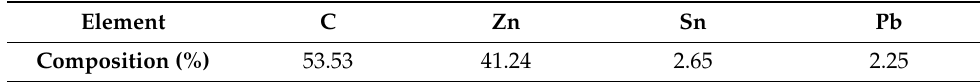
Table 3. Chemical composition of